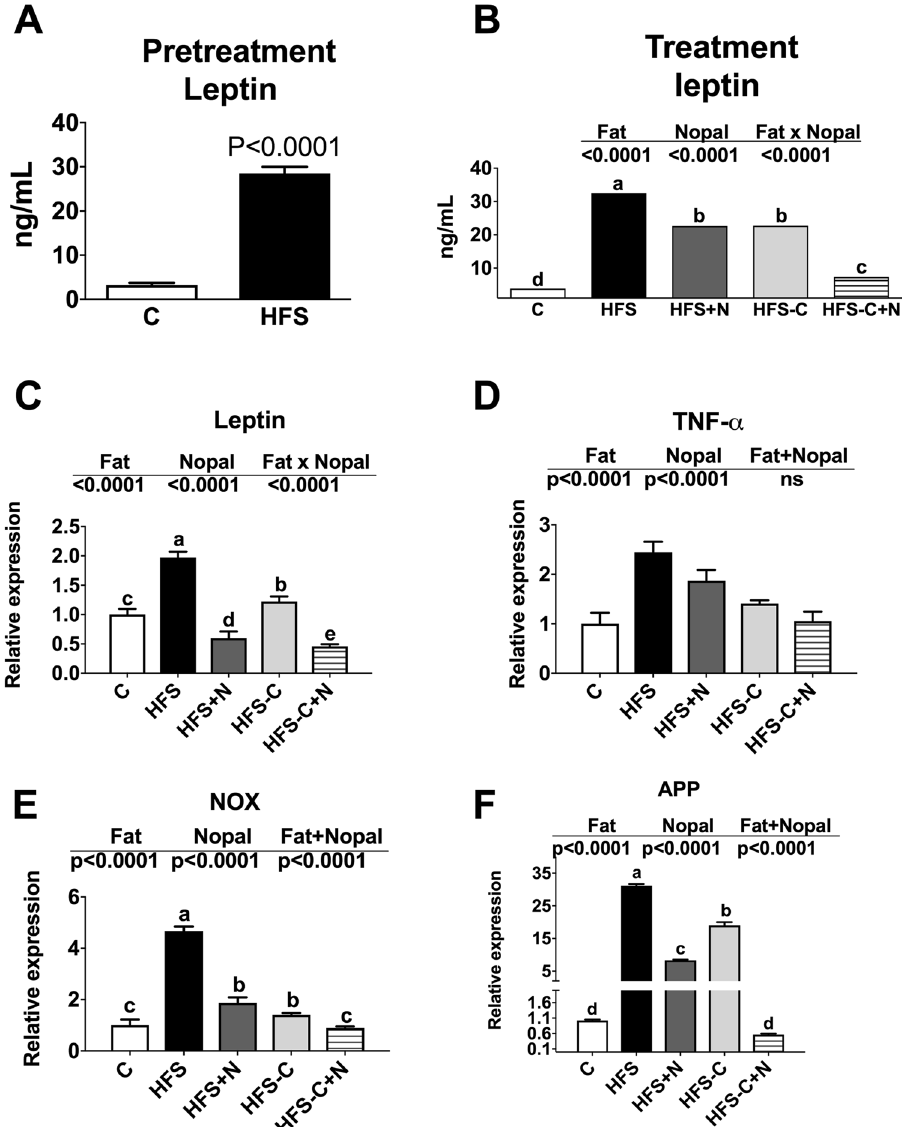
Figure 7. Effect of nopal consumption on serum leptin and expression of genes of inflammation and oxidative stress in adipose tissue. Panel (A) and (B) show the concentration of fasting serum leptin after the pretreatment and treatment periods respectively. Relative mRNA abundance of ( C ) leptin, ( D ) Tnf- α , ( E ) NADPH oxidase ( Nox ) and ( F ) amyloid precursor protein ( App ) in adipose tissue of Wistar rats fed one of the following diets: control diet ( C ), high fat diet with 5% sucrose in drinking water (HFS), HFS + 5% nopal (HFS + N), and obese rats switched to C diet with (HFS-C + N) or without (HFS-C) 5% nopal. Data are expressed as mean ± SEM (n = 5/group). Comparisons among groups were analysed by 2-way ANOVA followed by Fisher’s PLSD test. Different letters indicate significant differences among groups (a > b > c > d), P < 0.05. Comparisons between two groups were analysed by student